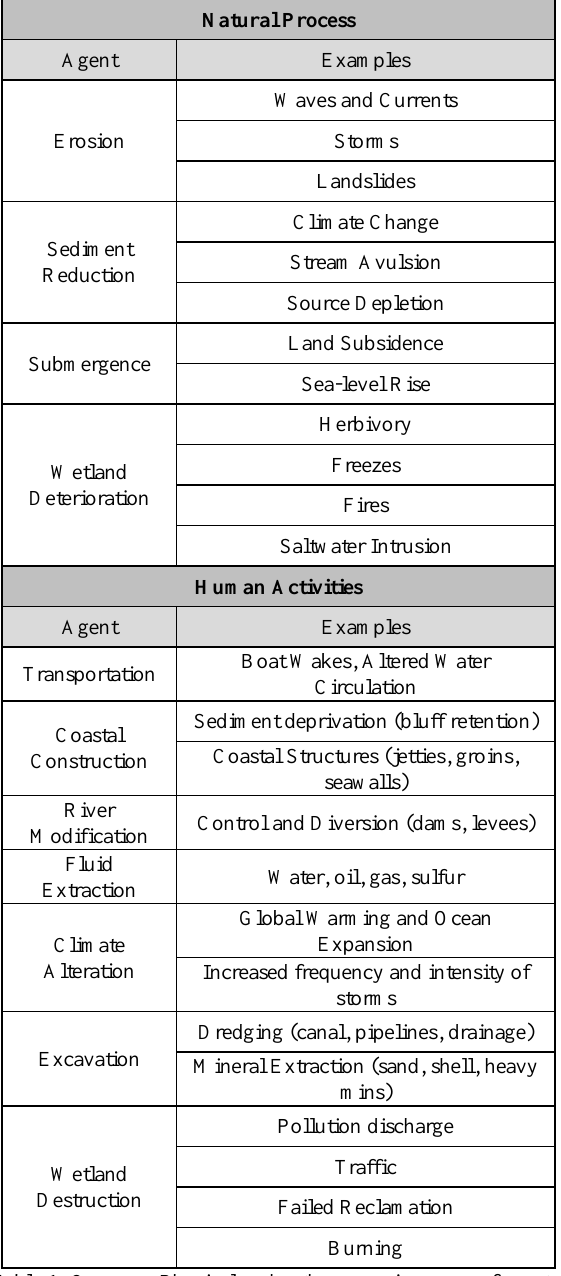
Table 1. Common Physical and anthropogenic causes of coastal land loss (Source: Morton, 2003)